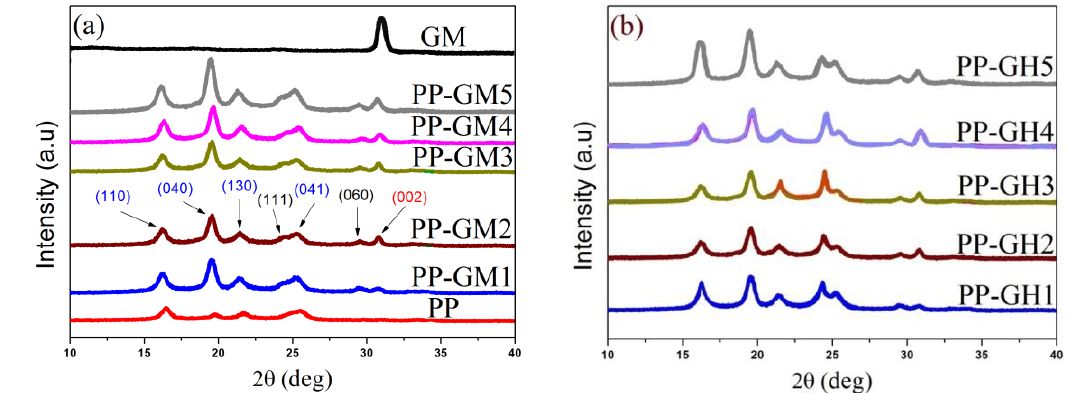
Figure 7. XRD curves of Virgin PP and PP nanocomposites reinforced with ( a ) M25 and ( b ) H25